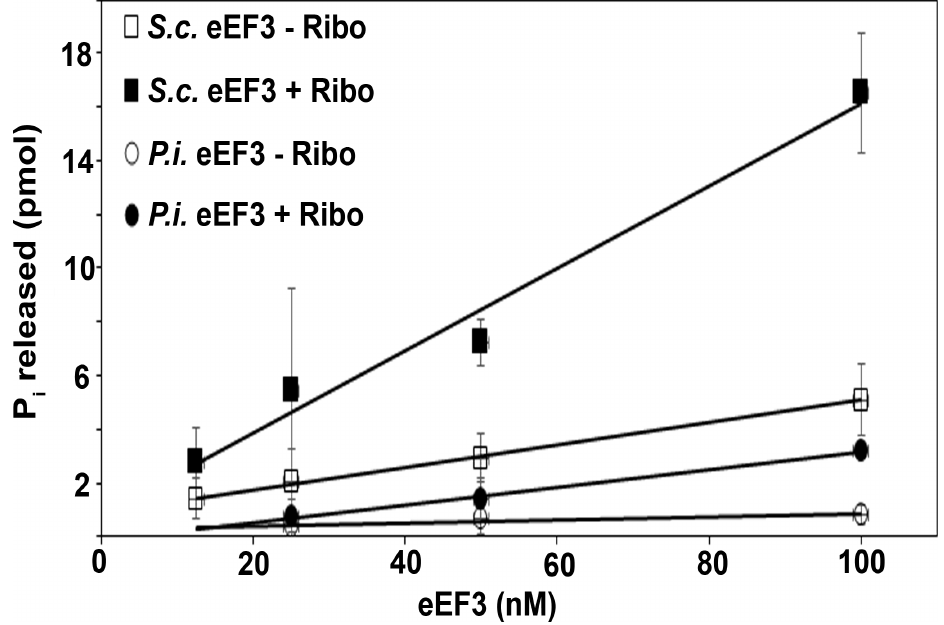
Fig 2. P . infestans eEF3 possesses ribosome-stimulated ATPase activity. ATPase activity of S . cerevisiae ( ■ ) and P . infestans (•) eEF3 was assayed in the presence(filled) or absence(empty) of S . cerevisiae ribosomes. The P i releasedwas measuredusing the PiColorLock Gold PhosphateDetection System. Reactionsincludedvarying amounts of eEF3, 25 nM ribosomes and 1 mM ATP and were carried out at room temperature for 30